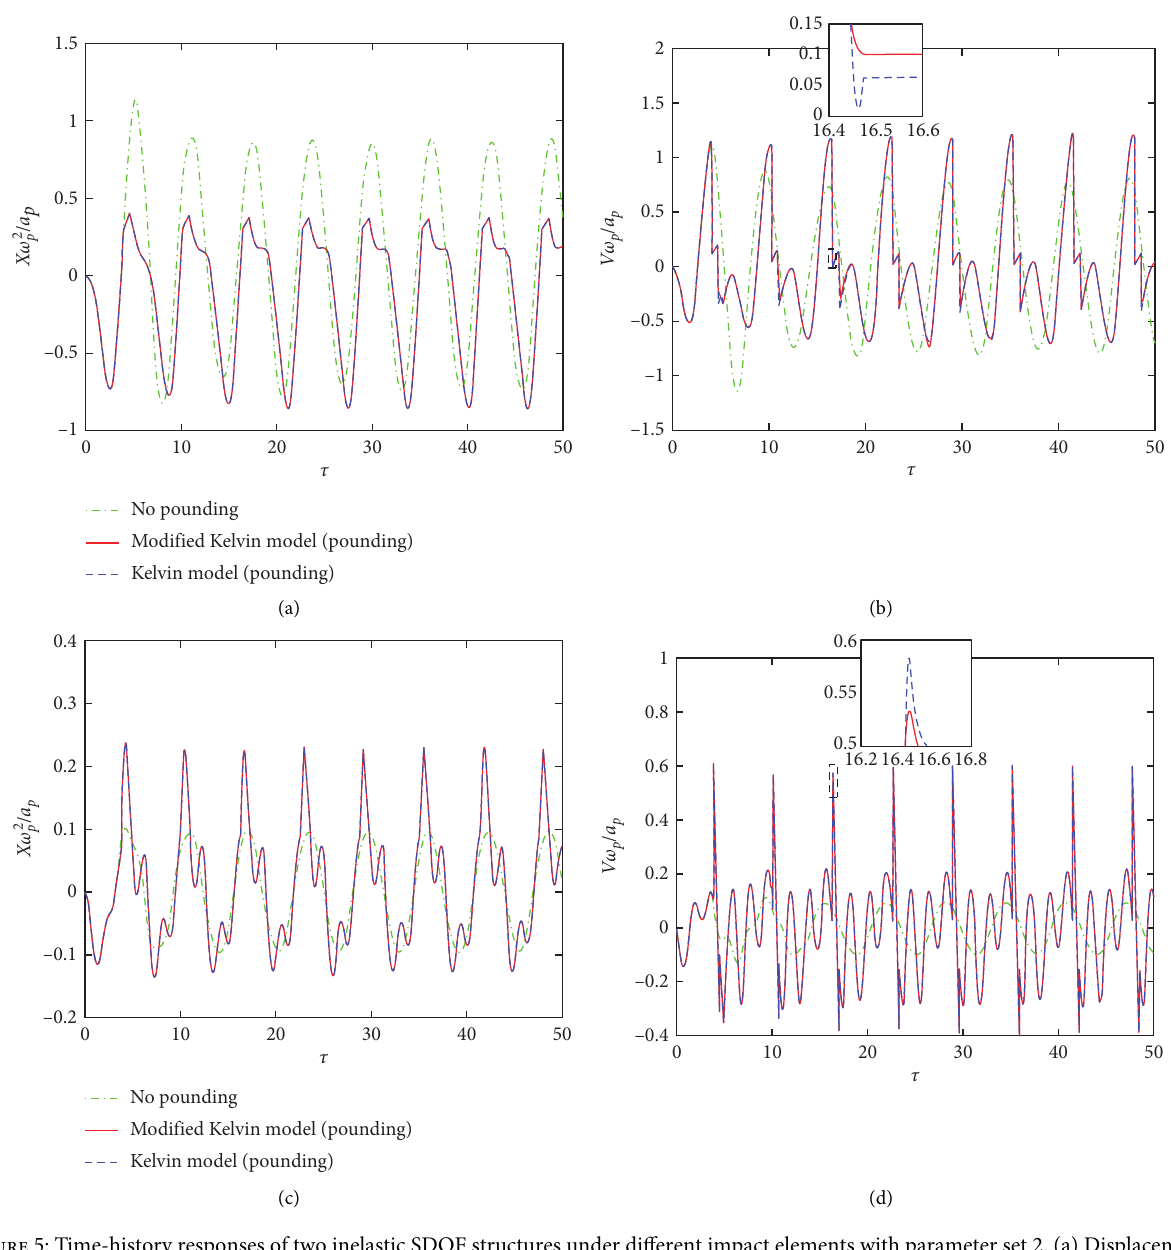
Figure 5: Time-history responses of two inelastic SDOF structures under different impact elements with parameter set 2. (a) Displacement histories of left-side structure. (b) Velocity histories of left-side structure. (c) Displacement histories of right-side structure. (d) Velocity histories of right-side